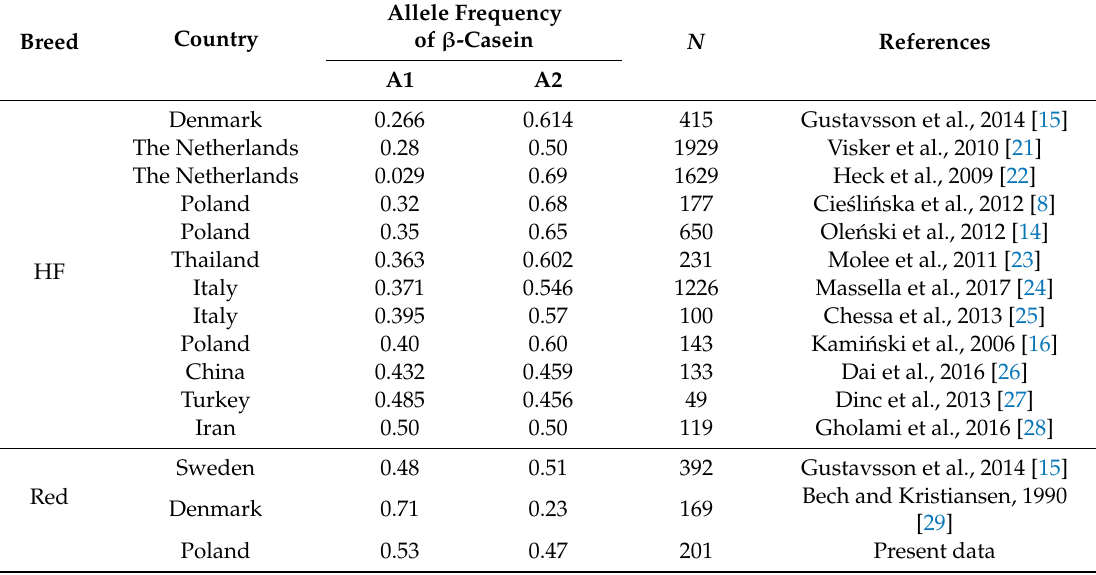
Other variants of the β -casein gene are not